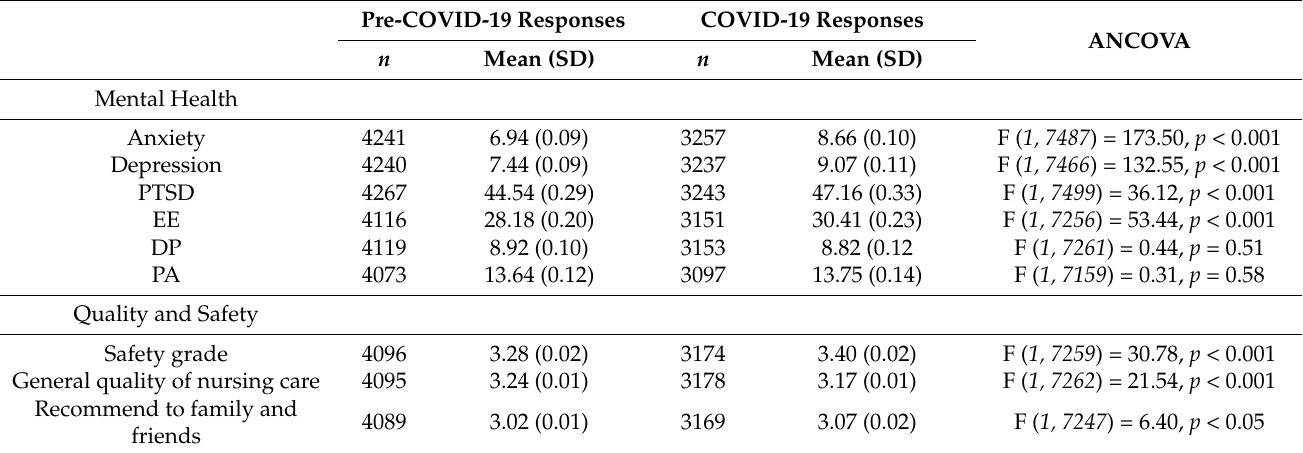
Table 2. Comparisons of mental health symptoms and quality safety ratings before and during